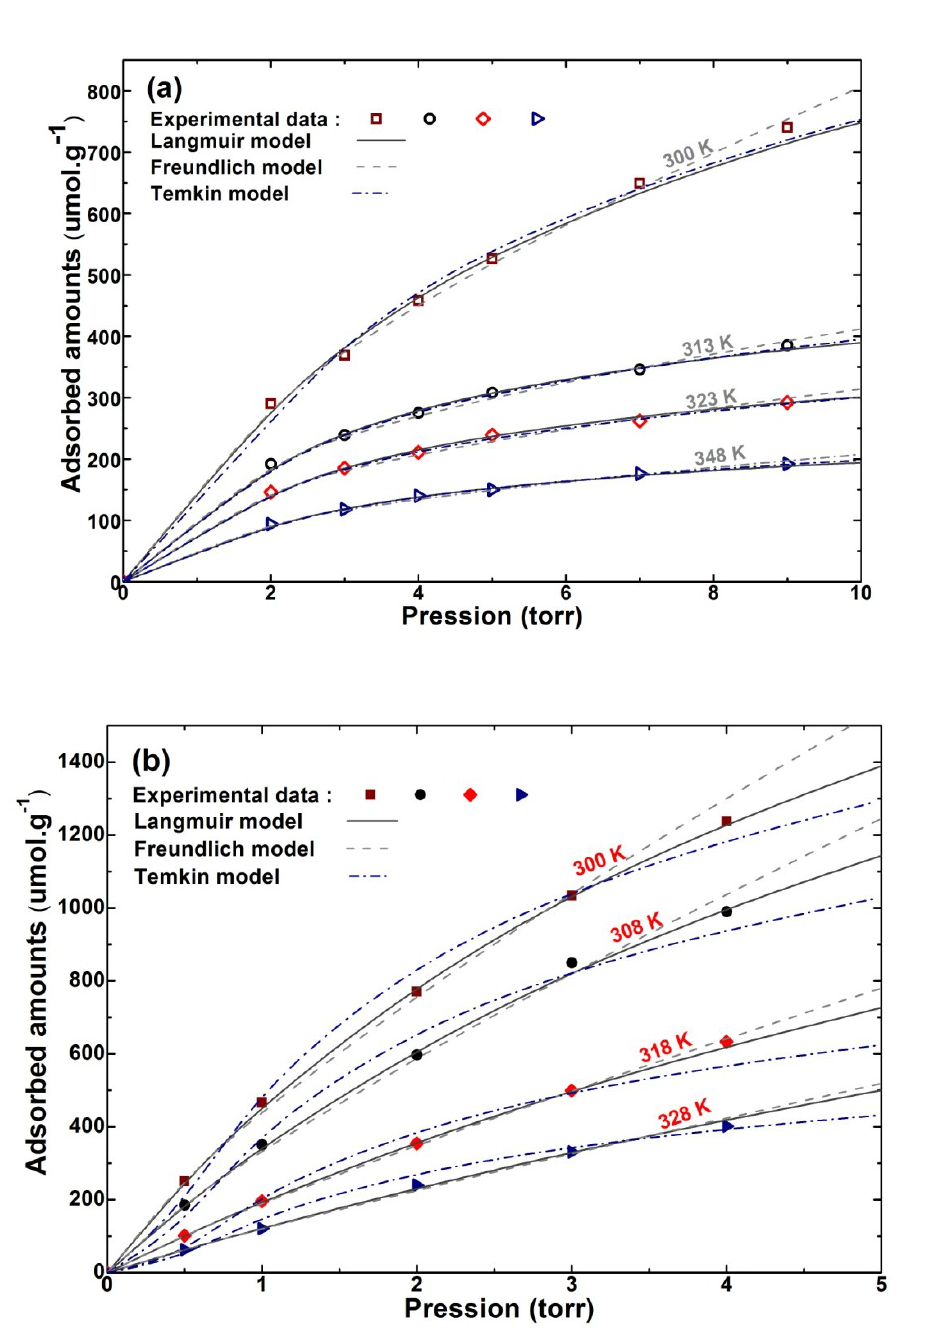
Figure 5. ( a ) Experimental and modeled adsorption isotherms obtained with bentonite clay at different temperatures. ( b ) Experimental and Modeled adsorption isotherms obtained with silica at different